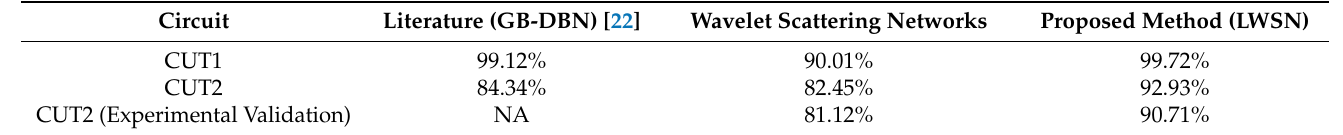
Table 3. Fault diagnosis accuracy of LWSN and comparison with other methods.